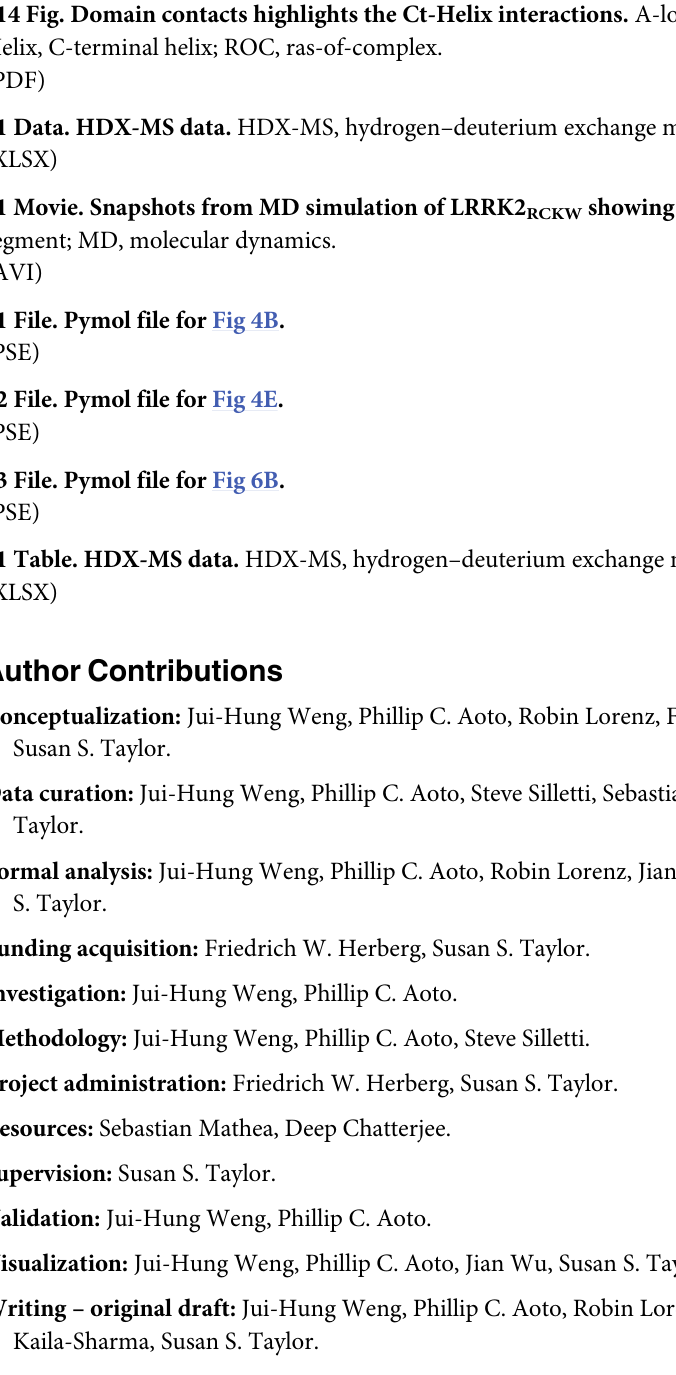
S13 Fig. Three rigid bodies of LRRK2 plex. (PDF) S14 Fig. Domain contacts highlights the Ct-Helix interactions. A-loop, activation loop; Ct- Helix, C-terminal helix; ROC, ras-of-complex.